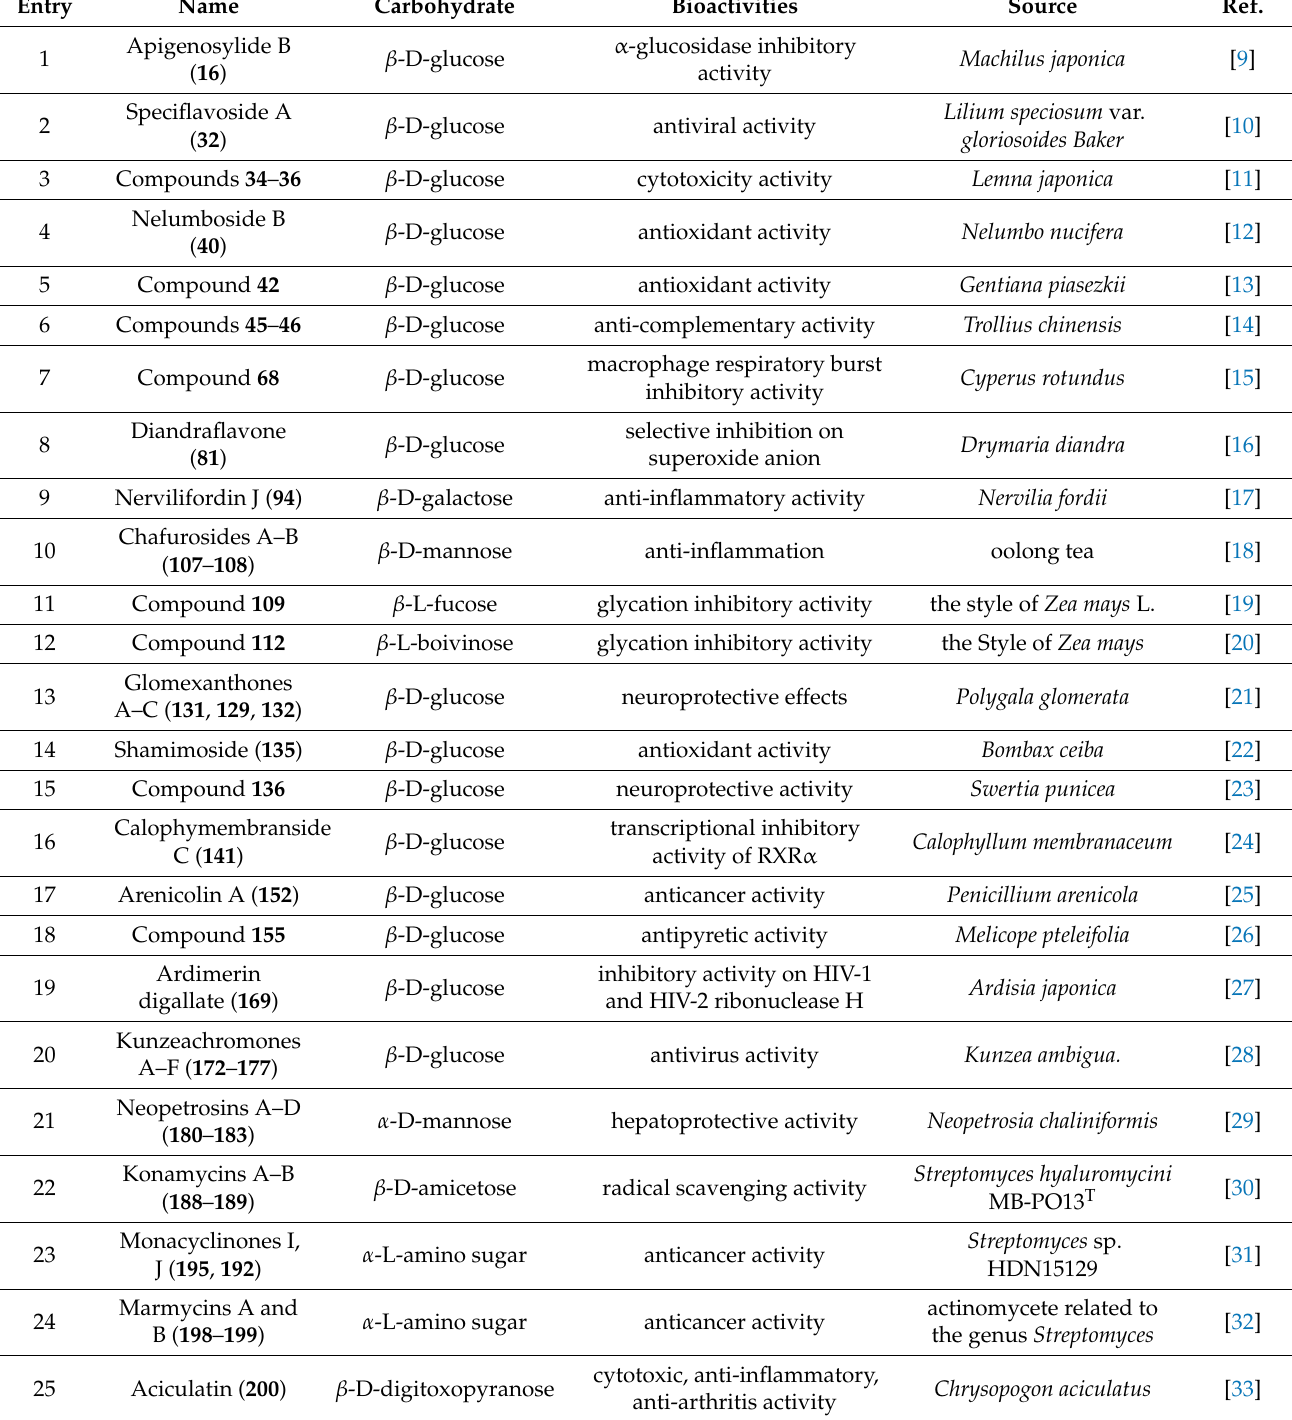
Table 1. Structures, Bioactivities, Sources of Aryl- C -glycoside